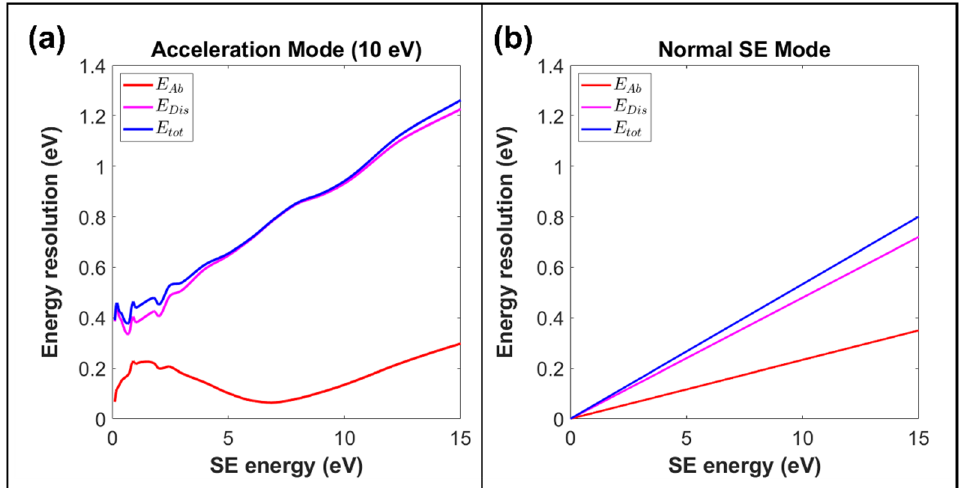
Figure 6. Simulated spectrometer energy resolution as a function of SE energy. Component aberration resolution and aperture energy dispersion parts of the total energy resolution are also shown. ( a ) Acceleration mode, where the pass energy of the SEs is increased by 10 eV. ( b ) Normal SE mode of operation, where the pass energy is equal to the SE energy.